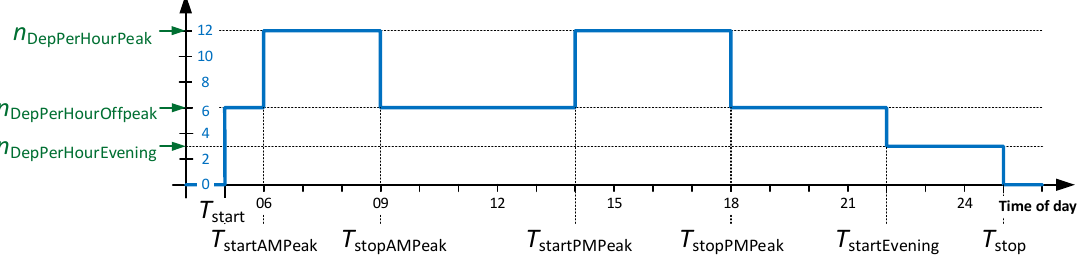
Figure 2. The generic way of describing the timetable which is used in the TCO model.